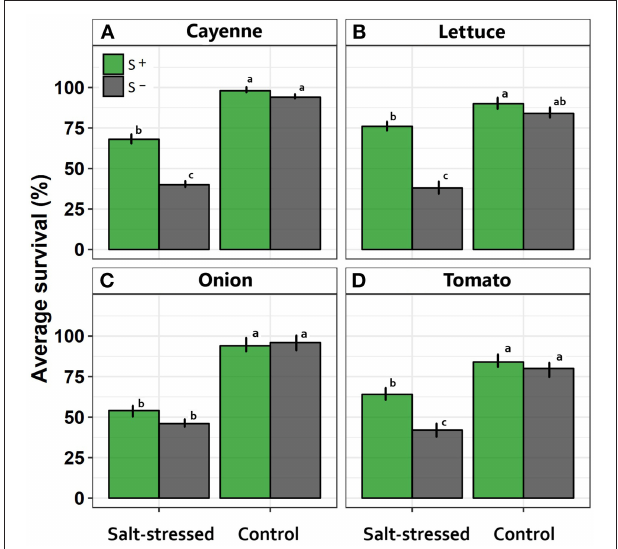
FIGURE 1 | Effects of saline treatment (control vs. salt-stressed) and inoculation with a mix of Antarctic microorganisms (S– vs. S + plants) on survival probability along time, in (A) cayenne, (B) lettuce, (C) onion, and (D) tomato crops. Different lowercase letters indicate significant differences between treatments (Tukey HSD tests; α = 0.05) independently for each species. Error bars represent ± SE values.